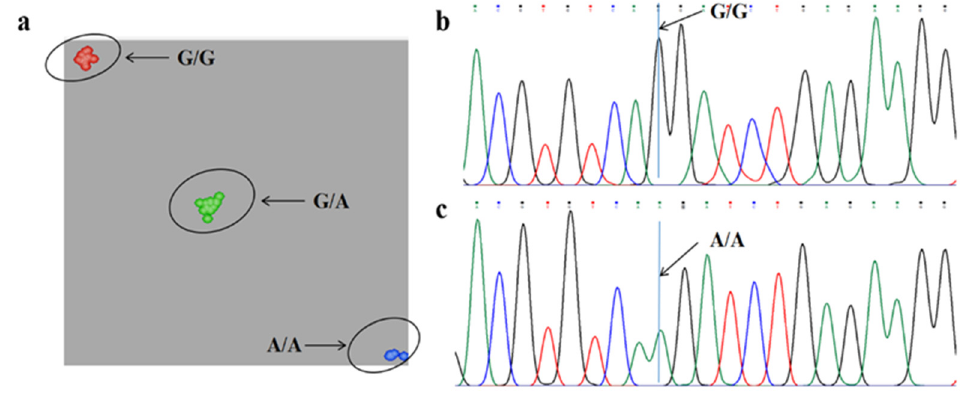
Figure 2. KASP genotyping results confirmed by Sanger sequencing. ( a ) KASP genotyping result of CsSNP40, ( b ) Sanger sequencing of SNP site G/G, ( c ) Sanger sequencing of SNP site A/A.